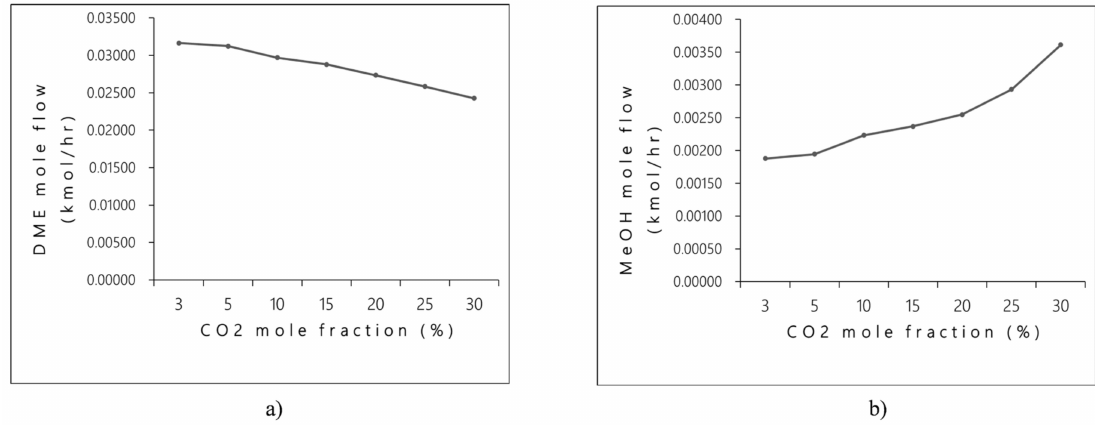
Figure 11. Influence of CO 2 mole fraction on ( a ) DME and ( b ) methanol mole flow at the outlet of the